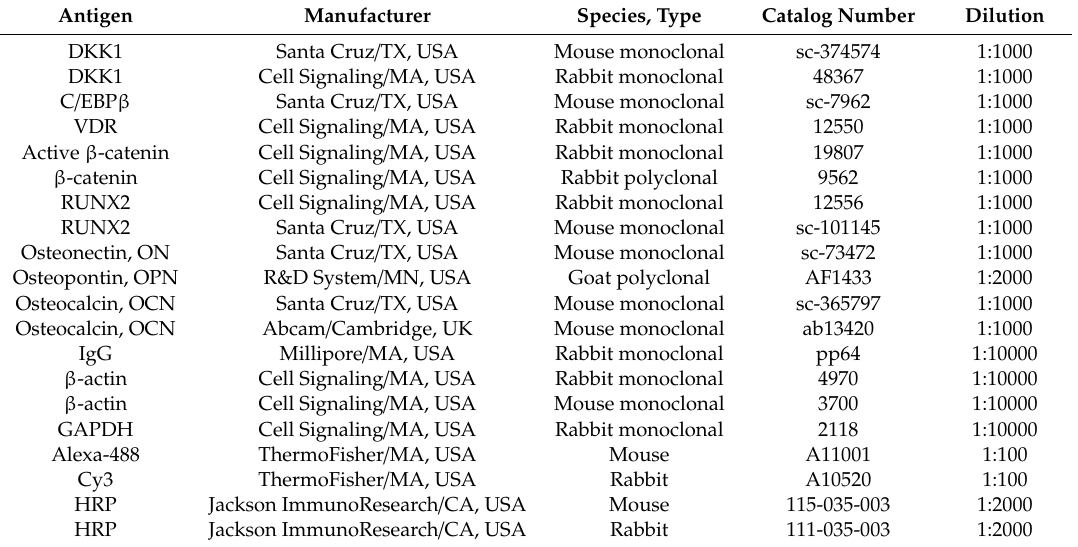
Table 1. Primary and secondary antibodies used in IB, IF, ChIP.